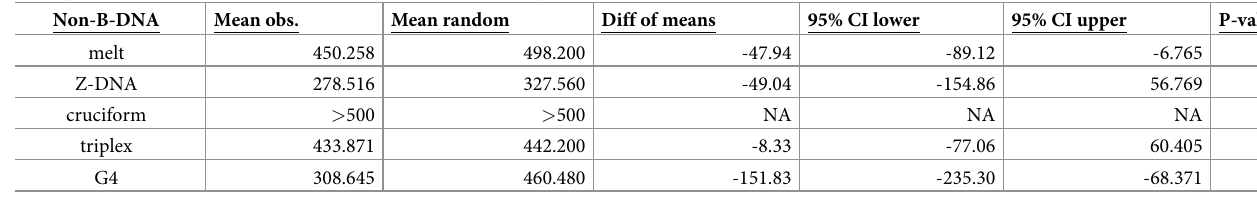
Average distance to closest non-B-DNA structure with probability / relative score > 0.2